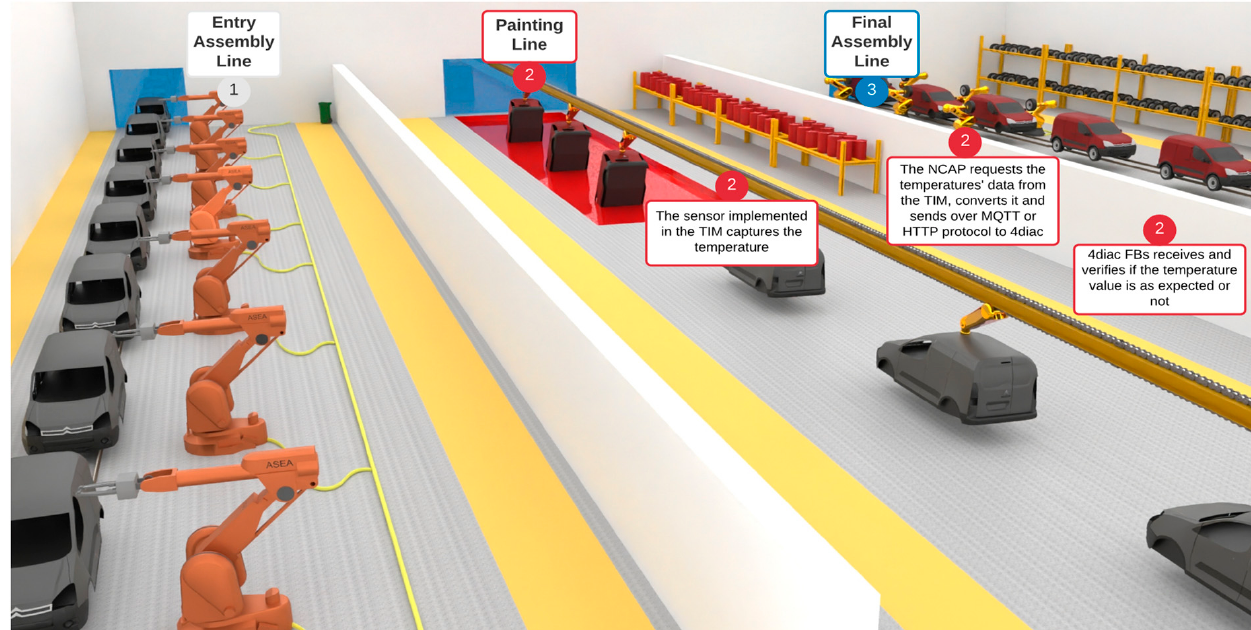
Figure 3. Case study representing a car painting line in a production plant.